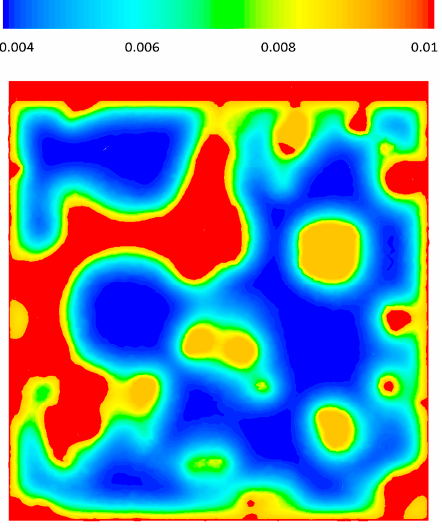
Figure 9. O 2 mass fraction on a cross-sectional plane, x = 0.